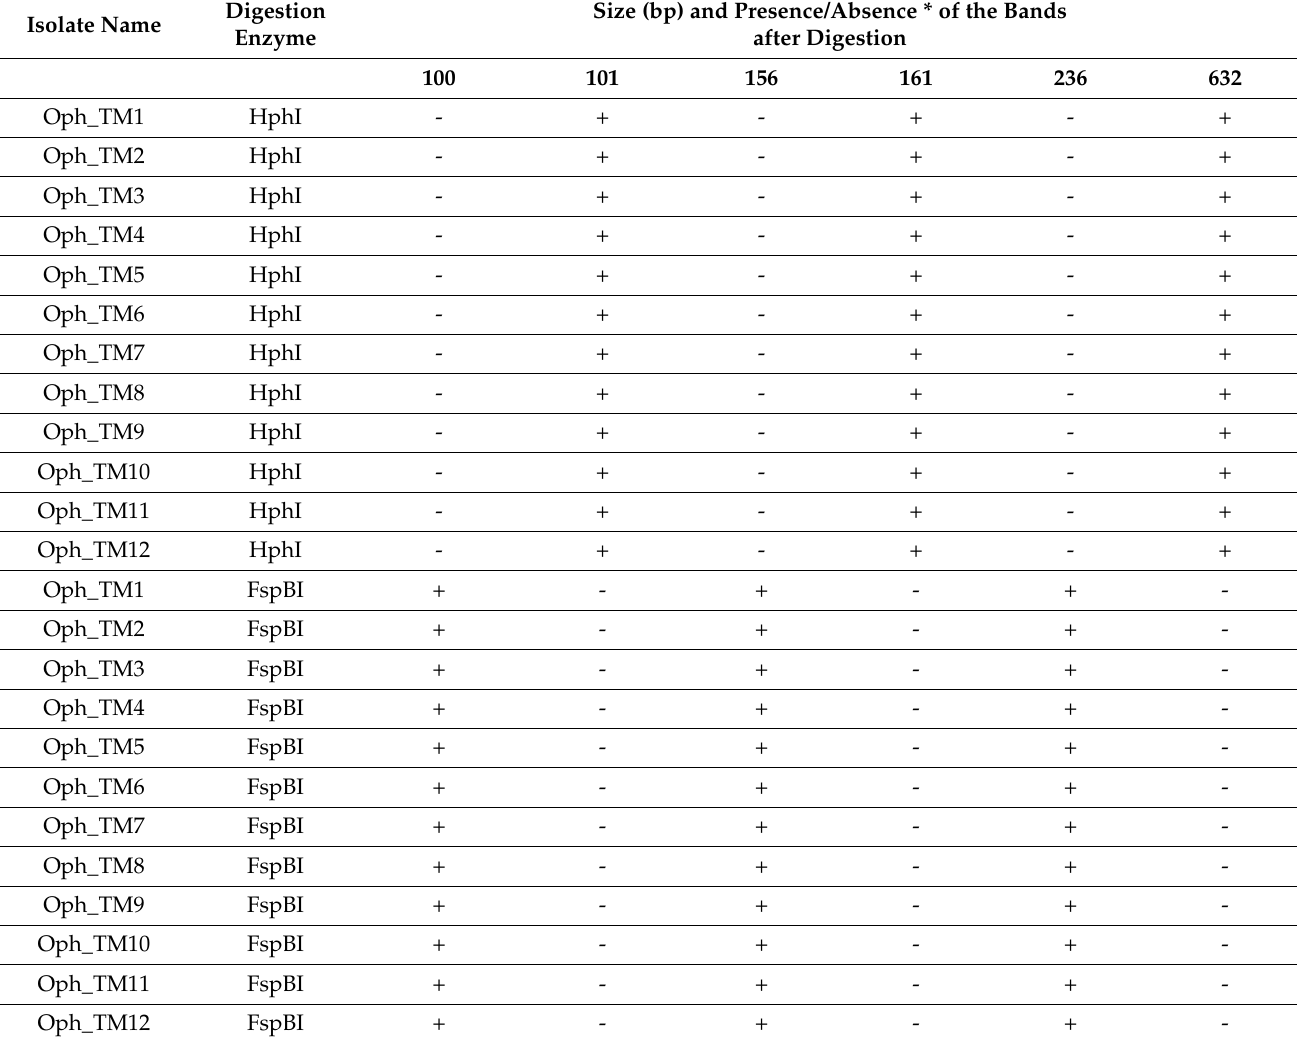
Table 3. Results of the PCR-RFLP analysis of the cu and col1 genes of O . novo - ulmi isolates obtained from the experimental field of P ă durea Verde—Timisoara, Romania.